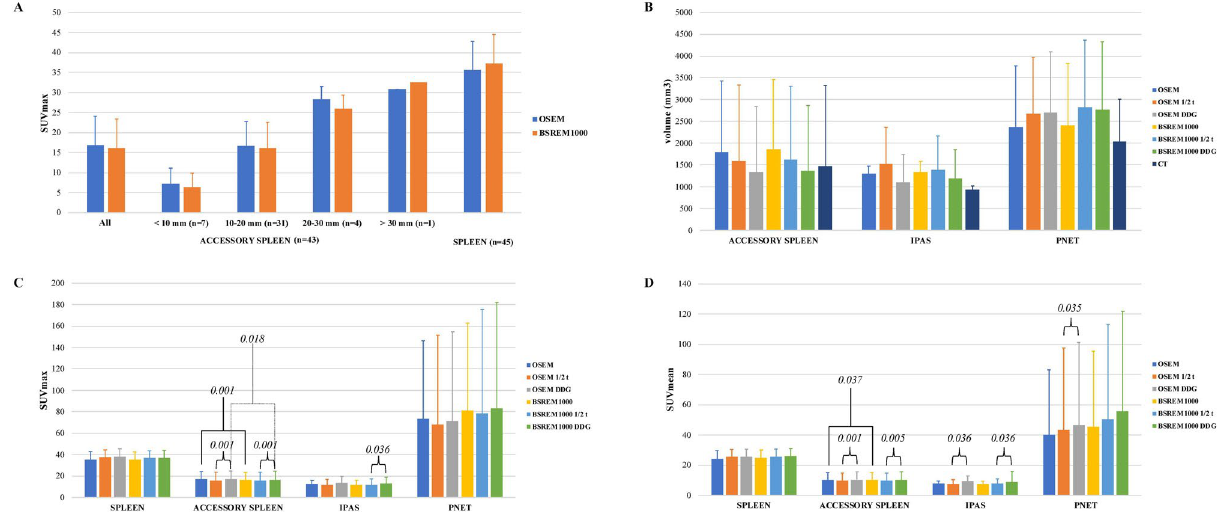
Figure 3. SUVmax of accessory spleens according to size (CT diameter of the lesions, mm) and spleen measured on OSEM and BSREM 1000 reconstruction ( a ). PET volume (mm 3 ) and CT volume ( b ), SUVmax ( c ) and SUVmean ( d ) of spleen, accessory spleen, IPAS and pNET among different PET reconstructions in the subcohort of exams acquired retrospectively (42 accessory spleens, 6 IPAS and 8 pNET). Significant P -values of Wilcoxon signed-ranks test, performed for accessory spleens, IPAS and pNET among different reconstructions, are reported in the SUVmax ( c ) and SUVmean panel ( d ). Note, for readability, only selected significant p-values of relevant comparisons are shown, which support the results reported in the